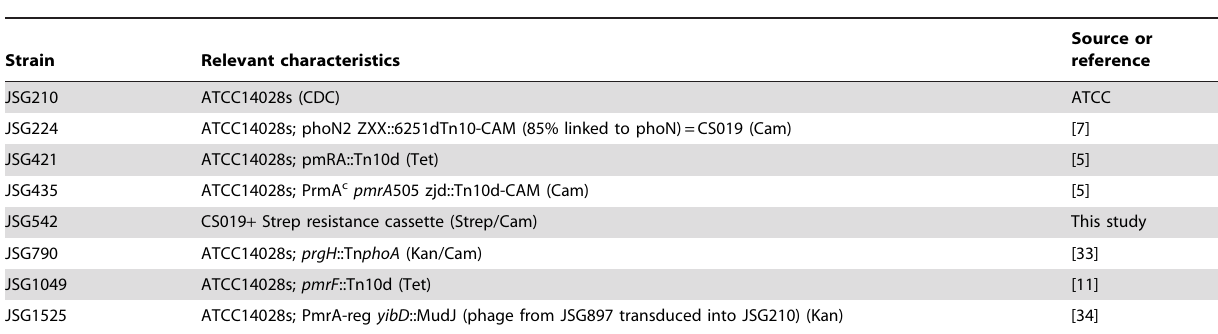
Table 1. Salmonella enterica serovar Typhimurium strains.